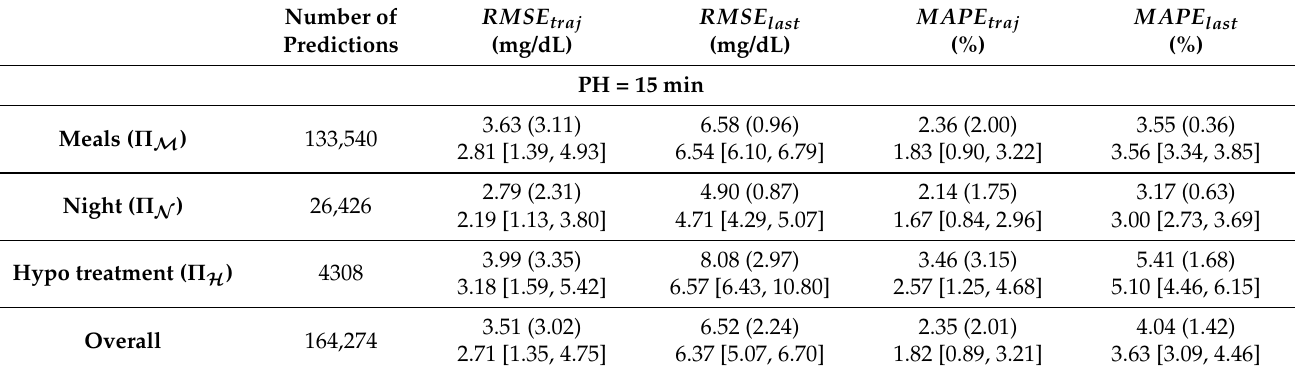
Table 5. Accuracy metrics of the glucose predictor for validation dataset 1